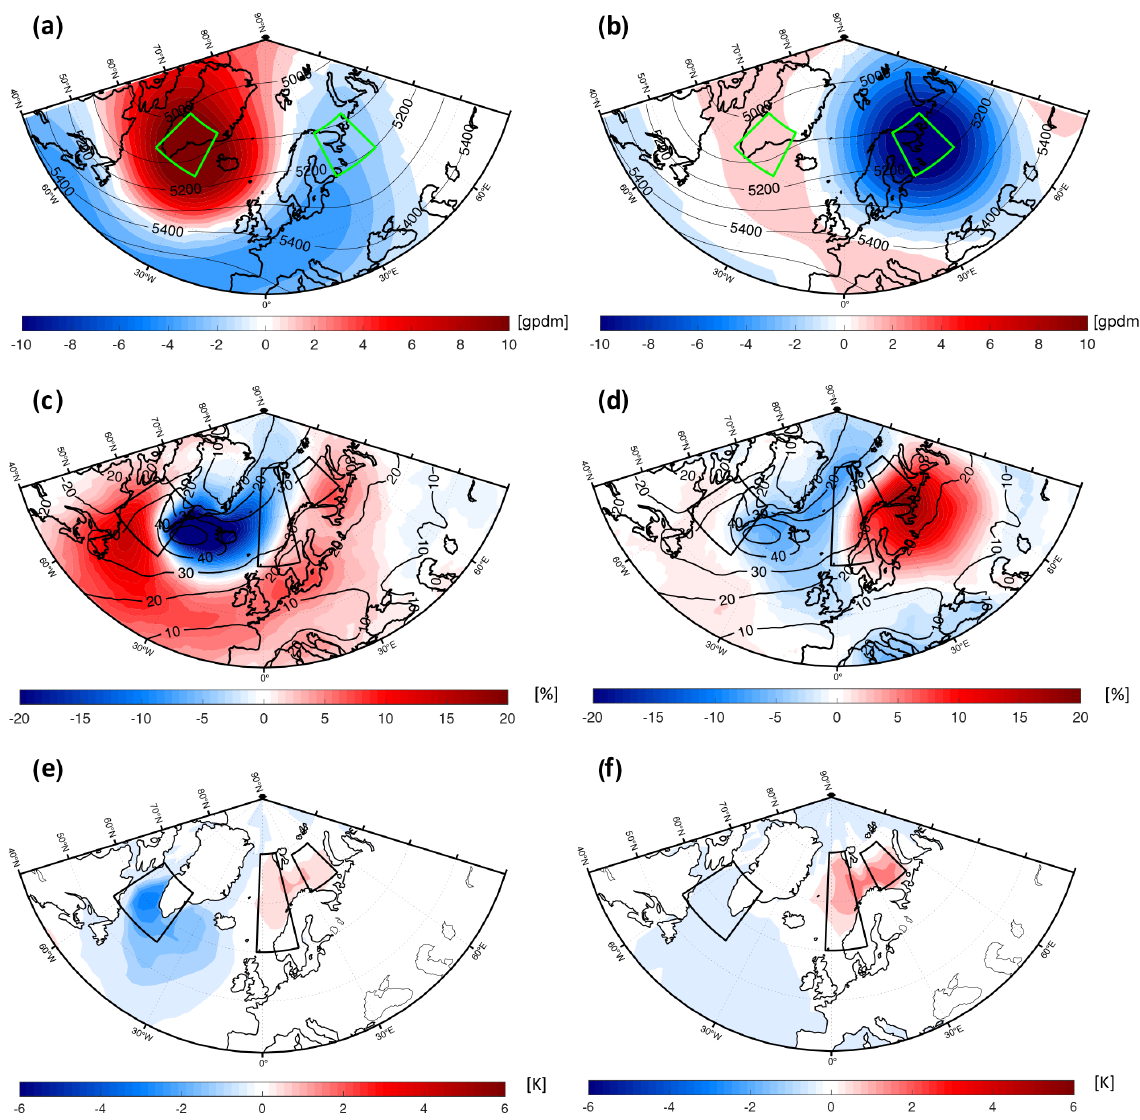
Figure 6. Regional patterns for the Greenland blocking (GB) and Scandinavian trough (ST) composites in DJFM. (a, b) Geopotential height anomaly at 500hPa (colour shading, in gpdm) and mean 500hPa geopotential height (black contours, in intervals of 100gpm) for DJFM in climatology, (c, d) mean cyclone frequency (shading, in %) and (e, f) MCAO index anomaly (colour shading, in K) for days with (a, c, e) positive 500hPa geopotential height anomaly averaged over the GB box and (b, d, f) negative anomaly averaged over the ST box, respectively. Black contours in (c) and (d) show the DJFM climatology of cyclone frequency (from 10%, in intervals of 10%). Only statistically significant values above the 95% level are shown (based on a two-sided Student’s t